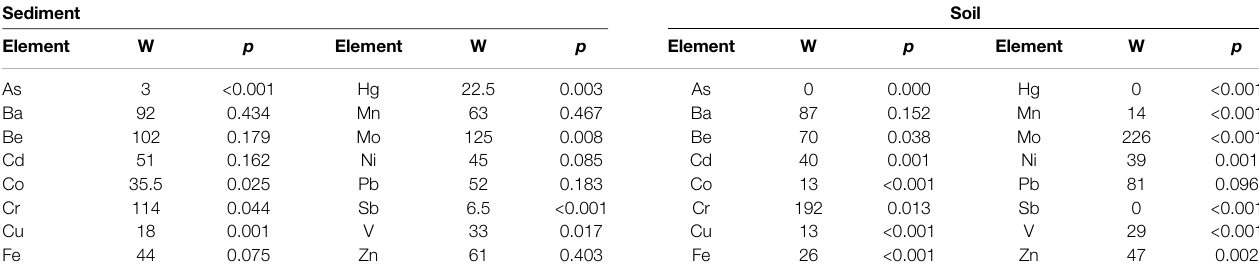
TABLE 4 | Summary of the p -values obtained from Mann-Whitney-Wilcoxon (MWW) Test used to verify the similarities in the distribution of the PHEs in HUR and KAD. Sediment Soil Element W p Element W p Element W p Element As Mn